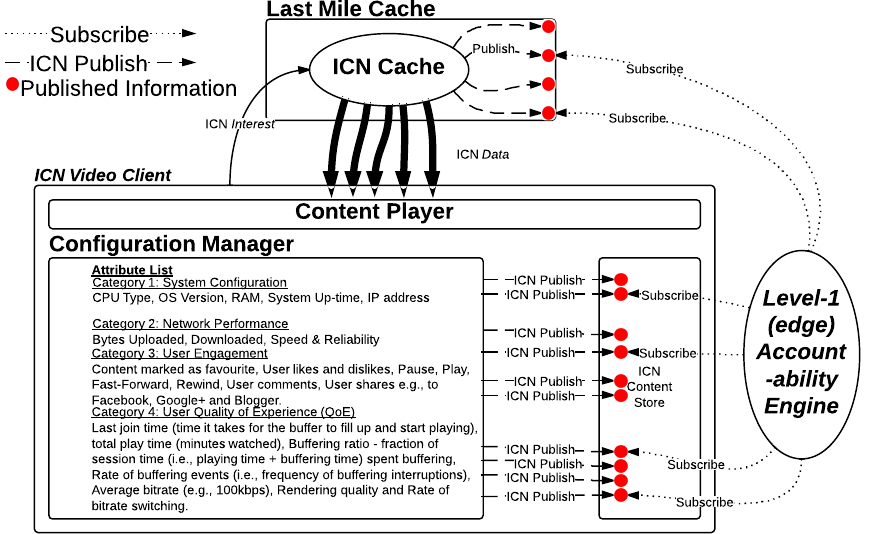
Fig. 2. The attribute values in categories identified here are published by ICN agents. The accountability engine subscribes to published data at ICN